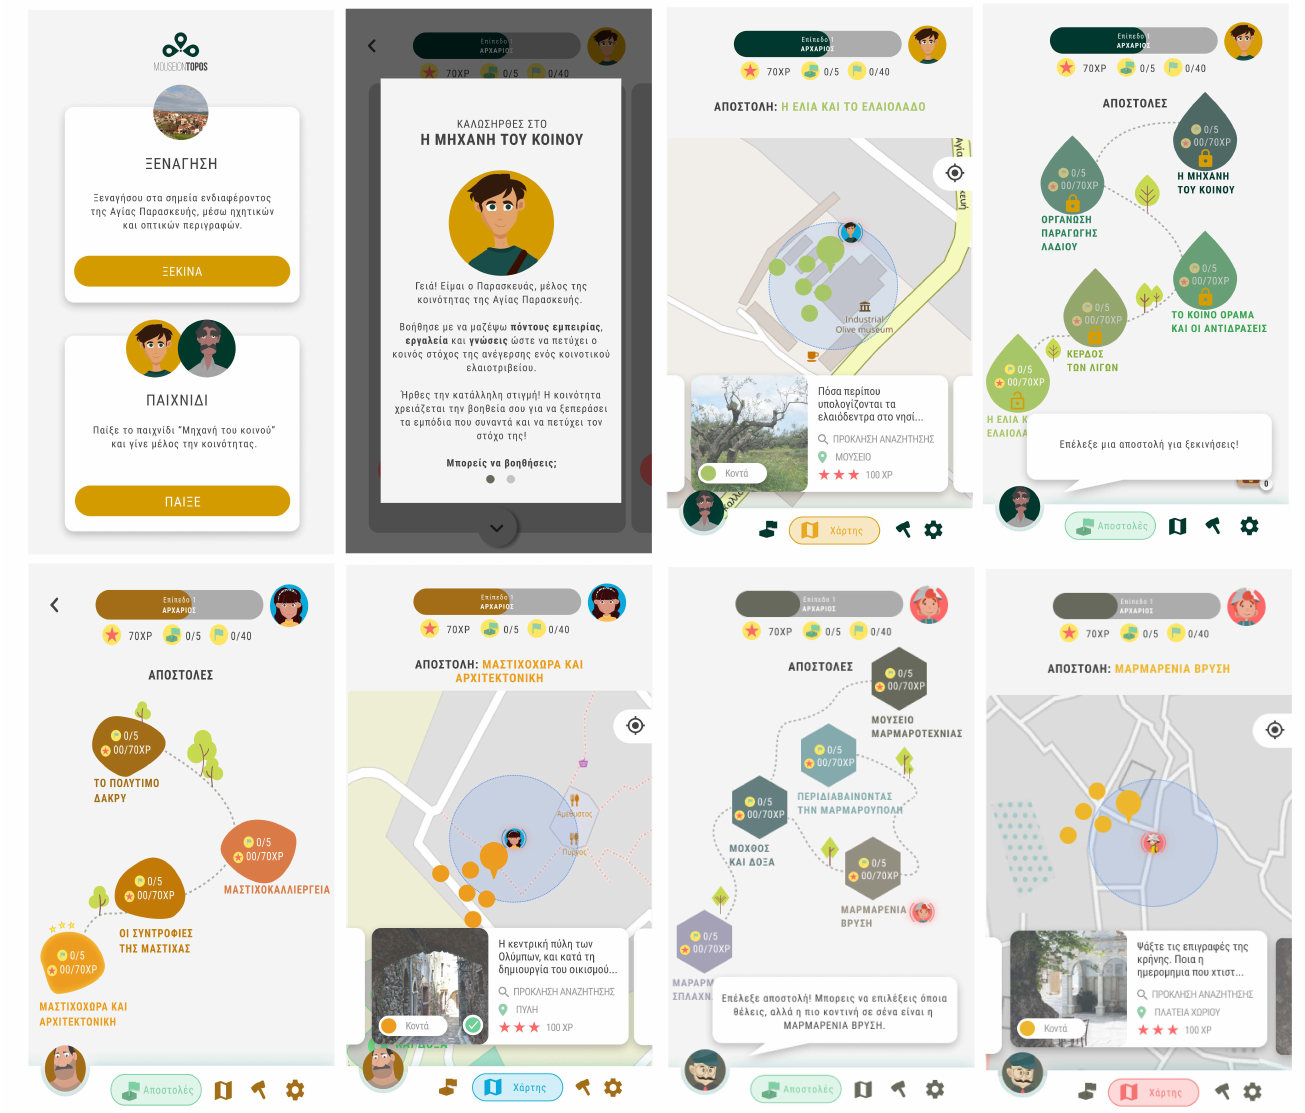
Figure 5. Detailed designs of some of the screens of the mobile games. Upper row: People’s Machine game (Mouseion Topos #Lesvos). From left to right: ‘Tour or Game’ screen; onboarding with digital character; missions map; and challenges view (map and list). Lower row: First two screens are the missions map and challenges view of the Mastic and Mastichochora game (Mouseion Topos #Chios). Last two screens are the missions map and challenges view of the game Explore the Marble Town (Mouseion Topos